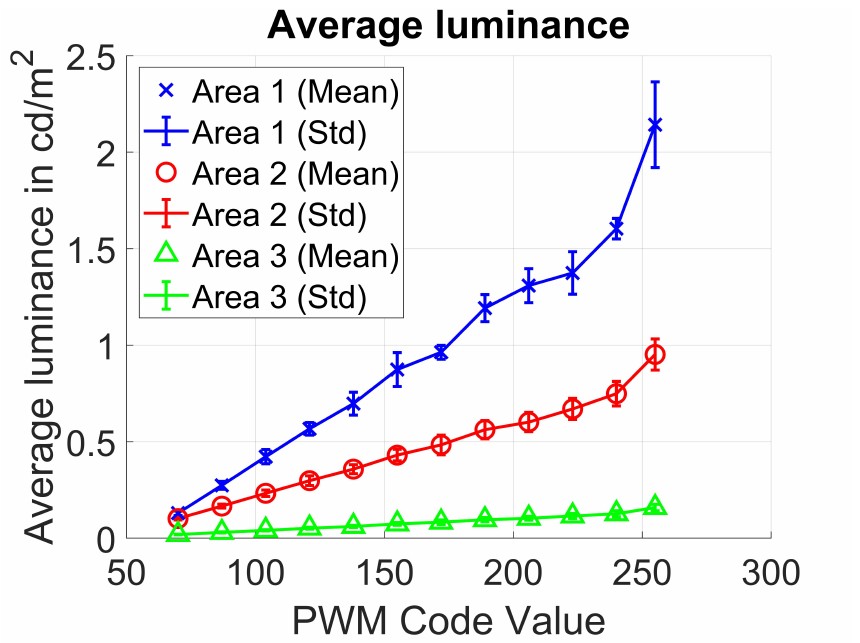
Figure 4. Mean luminance values (data points: crosses—area 1, open circles—area 2, triangles— area 3) and standard deviation (Std) as a function of the PWM code values representing the twelve different brightness settings of the static